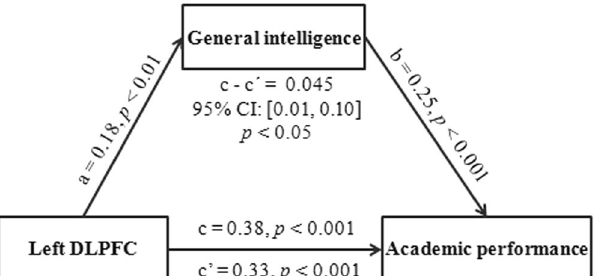
Figure 4. General intelligence mediates the relationship between the left DLPFC and academic performance. The panel shows that the left DLPFC affects academic performance through general intelligence. Here, we used the standardized regression coefficients to indicate the paths between variables, and all paths (a, b, c and c’) were significant. The indirect effect (c − c’ or a × b) was significant. Academic performance was measured using the Chinese National College Entrance Examination (CNCEE) score. Gender, age and the total gray matter volume were controlled for. DLPFC = dorsolateral prefrontal